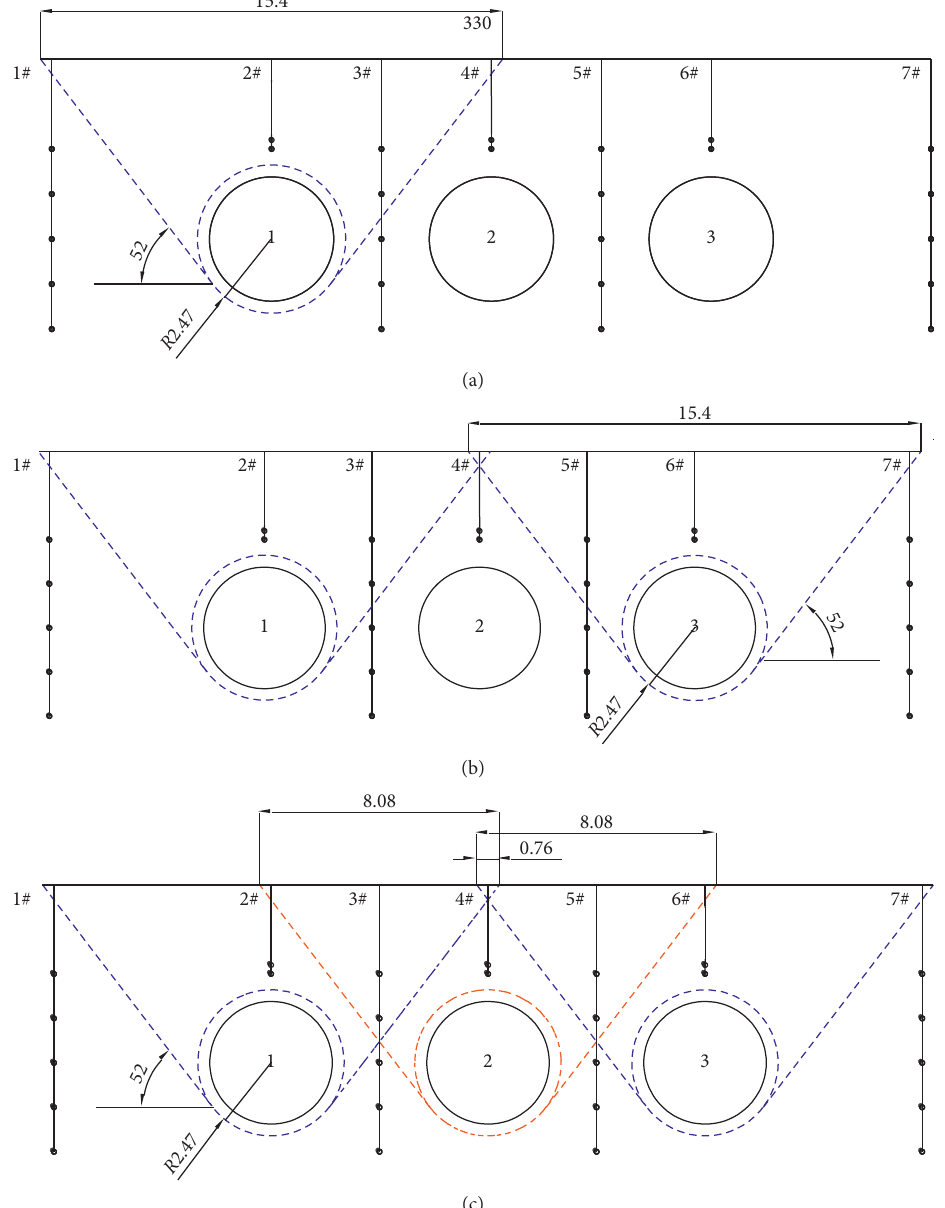
Figure 15: Calculation map of lateral disturbance range and overlapping range. (a) Hole 1 excavates. (b) Hole 3 excavates. (c) Hole 2